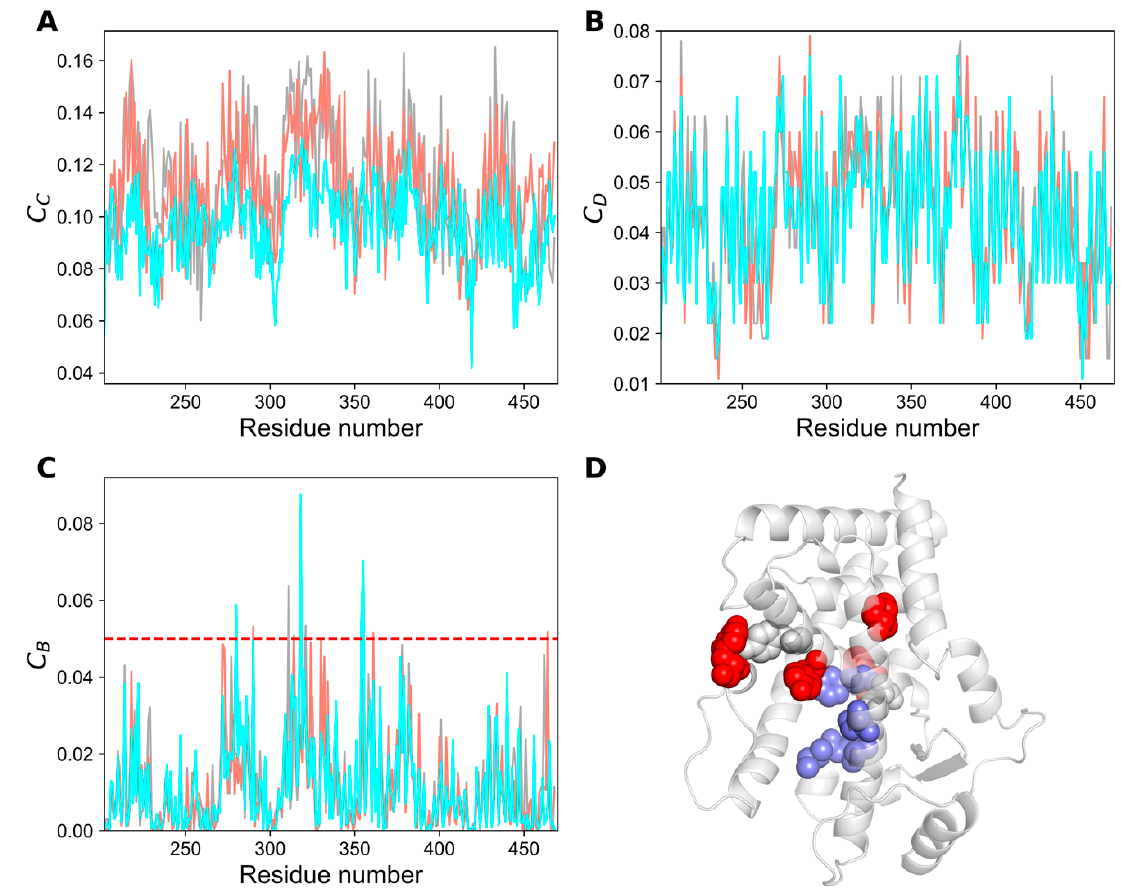
Figure 7. Network centrality analysis for three different systems of PPAR- α . ( A ) Closeness ( C c ), ( B ) degree ( C D ), and ( C ) betweenness ( C B ) centralities for each residue of the PPAR- α complexes are shown. ( D ) Residues with high C B ( ≥ 0.05) are depicted as spheres on the representative apo structure of PPAR- α . Gray, red, and slate blue spheres represent the residues with high C B values in apo, agonist-, and antagonist-bound forms of PPAR- α , respectively.